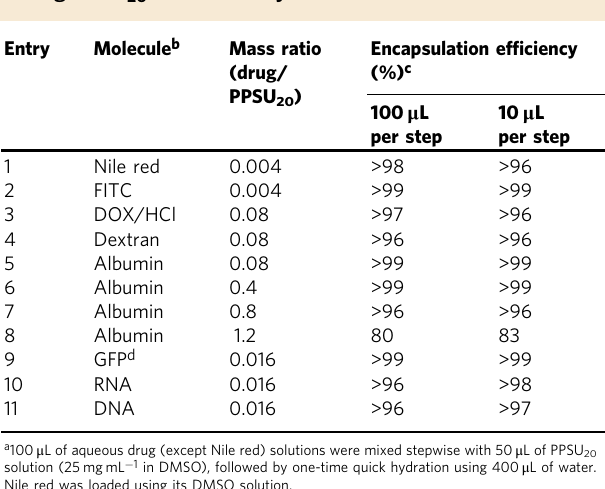
Table 1 Encapsulation ef fi ciency of molecules captured during PPSU 20 self-assembly a